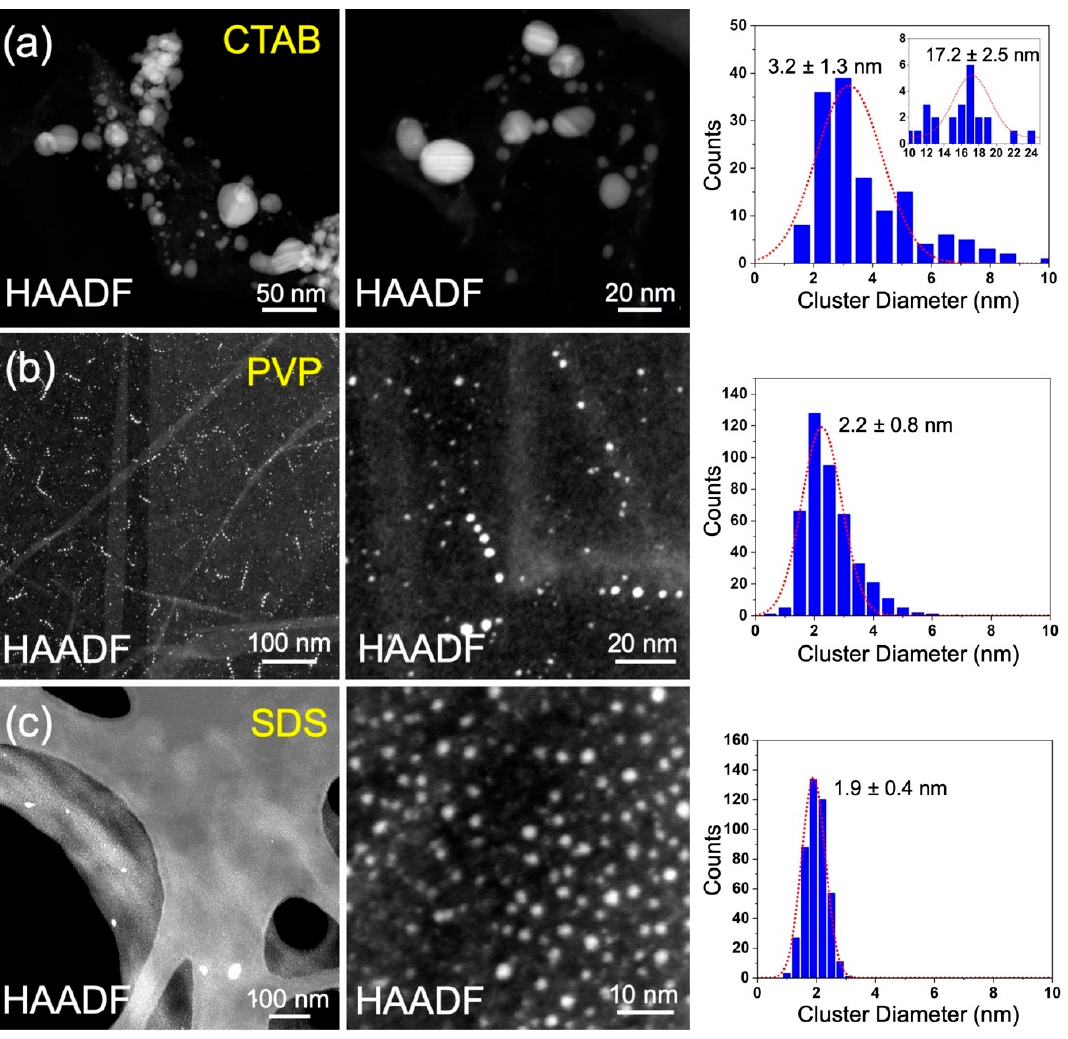
Figure 2. Typical HAADF-STEM images and size distributions for the Ag nanoparticles prepared using the aqueous pulsed plasma technique in the presence of CTAB ( a ), PVP ( b ), and SDS ( c ).